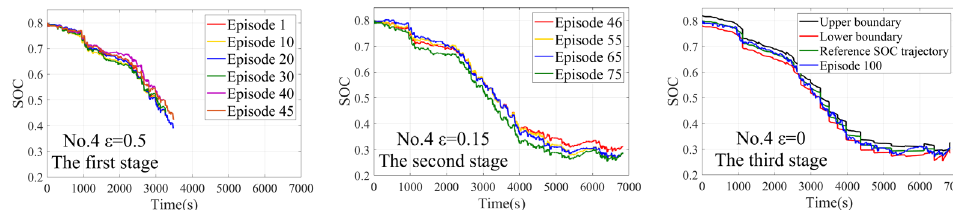
Figure 13. The training process of combined driving cycle 4.